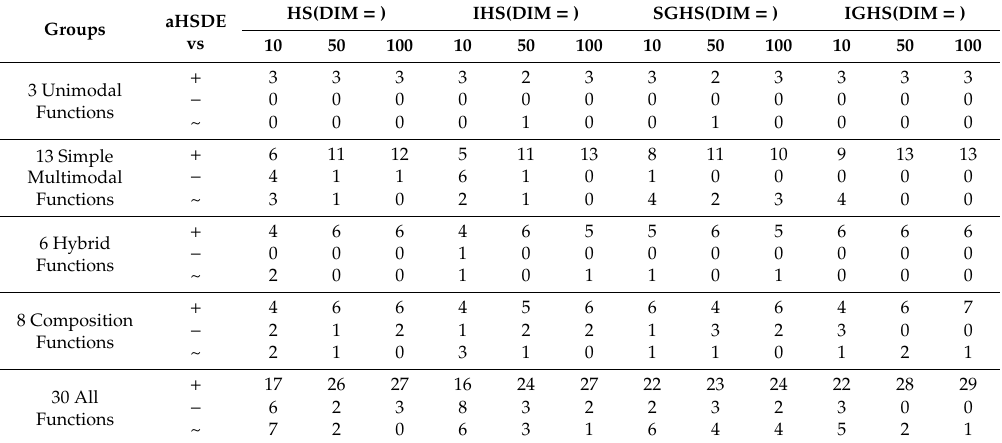
Table 2. Overall statistical comparison among aHSDE and HS, improved harmony search (IHS), self-adaptive global-best harmony search (SGHS) and IGHS on